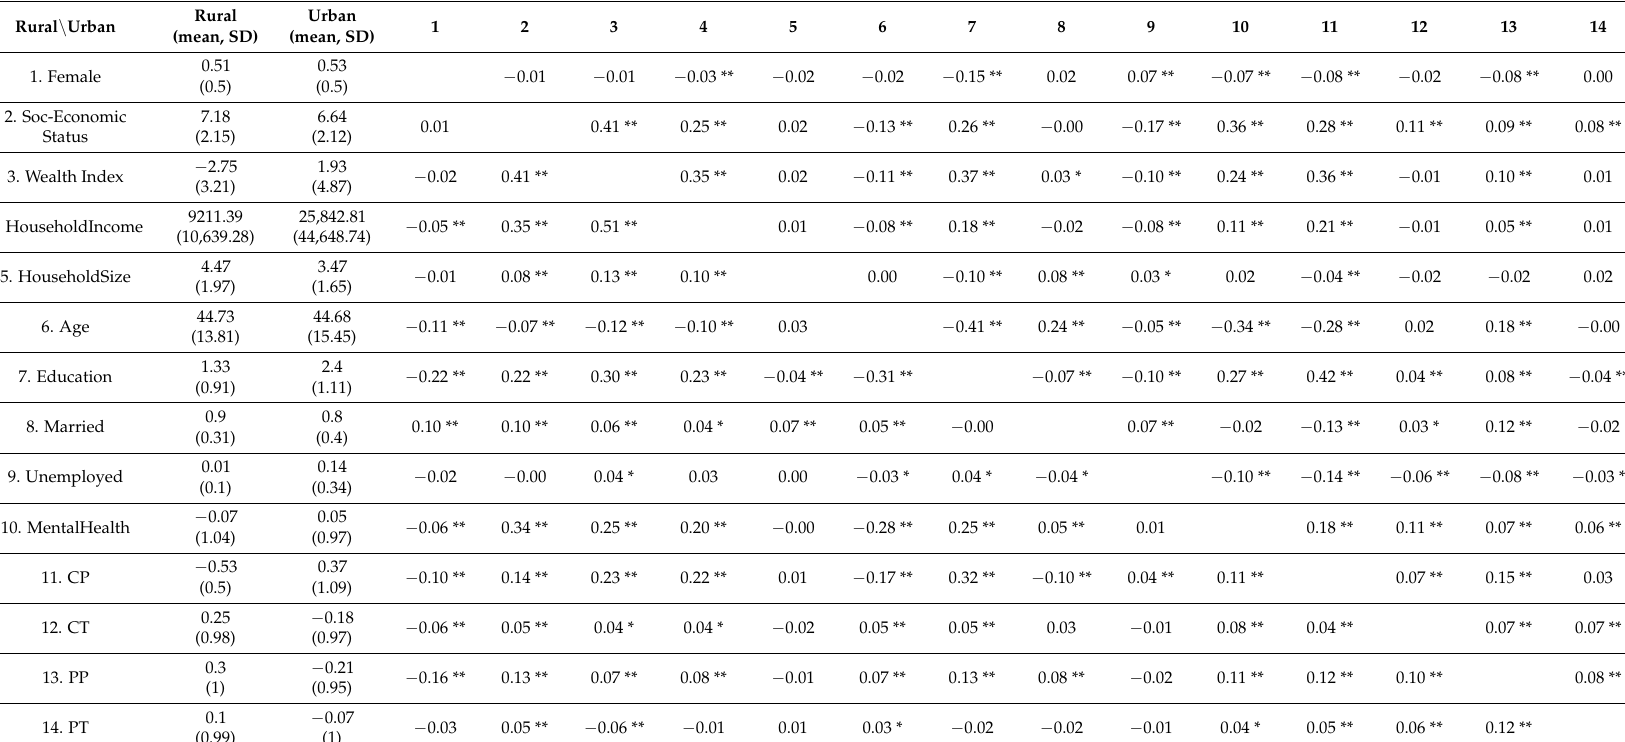
Table 4. Descriptive statistics and correlation